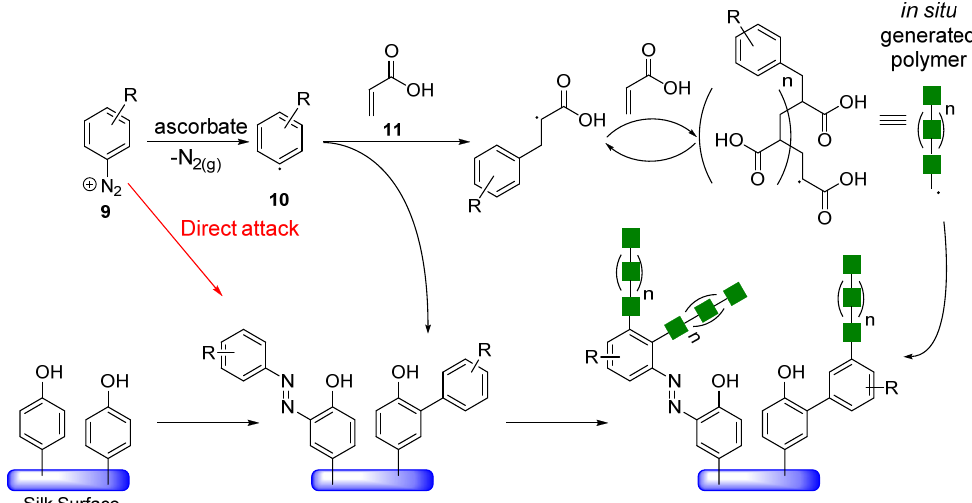
Figure 2. An overview of the chemical processes used in this study to modify the surface of silk fibroin membranes with poly(acrylic acid) 11.